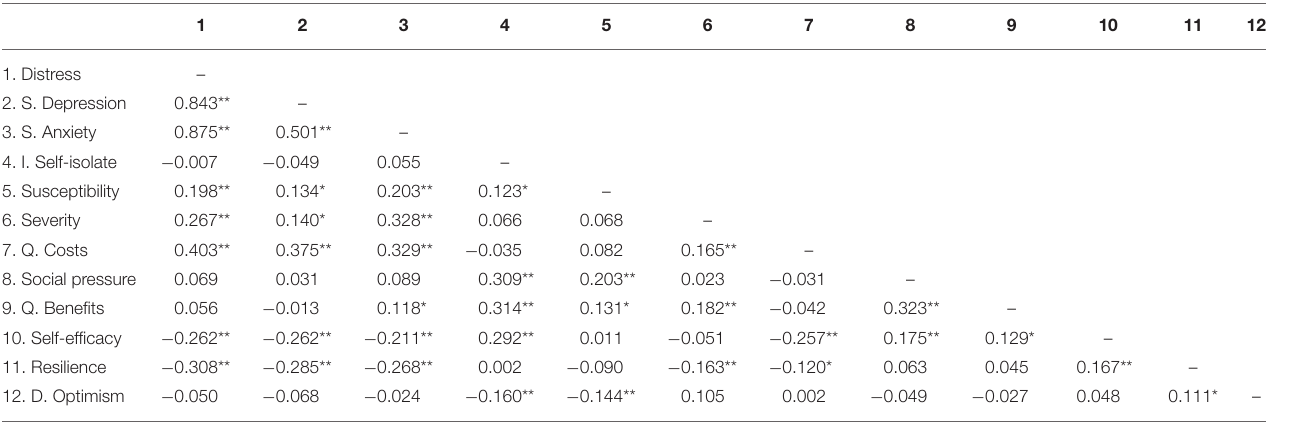
TABLE 4 | Spearman rank correlations of the variables in the